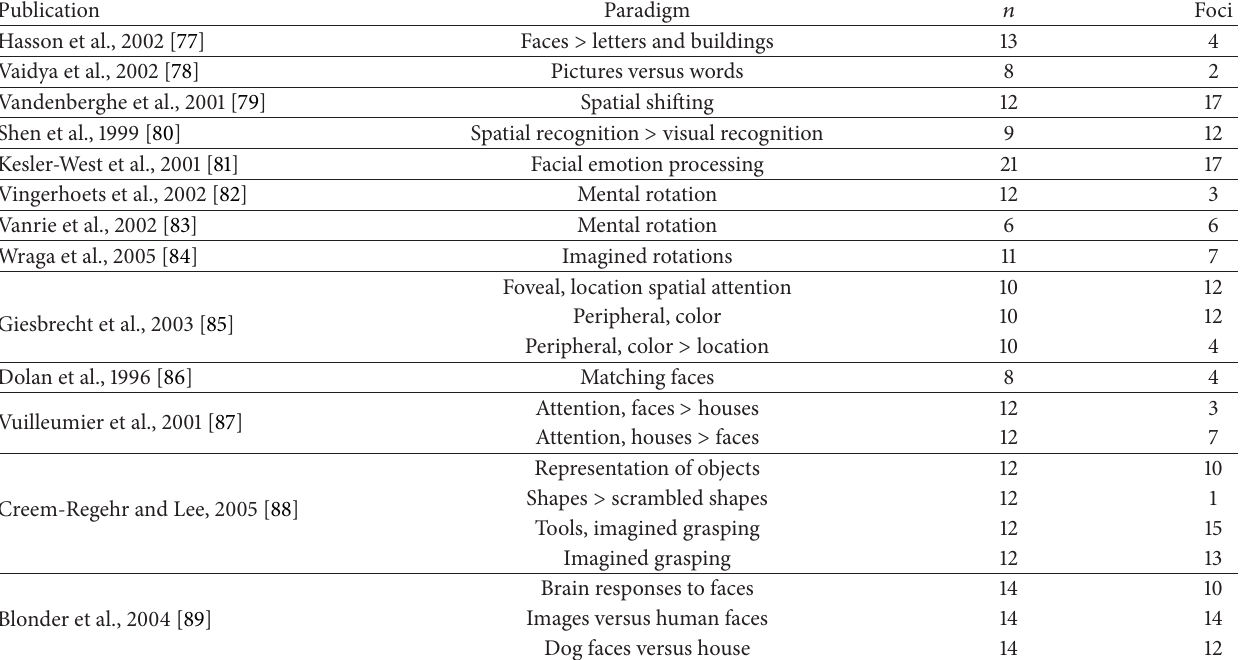
Table 2: Primary studies of visual perception paradigms included in the second